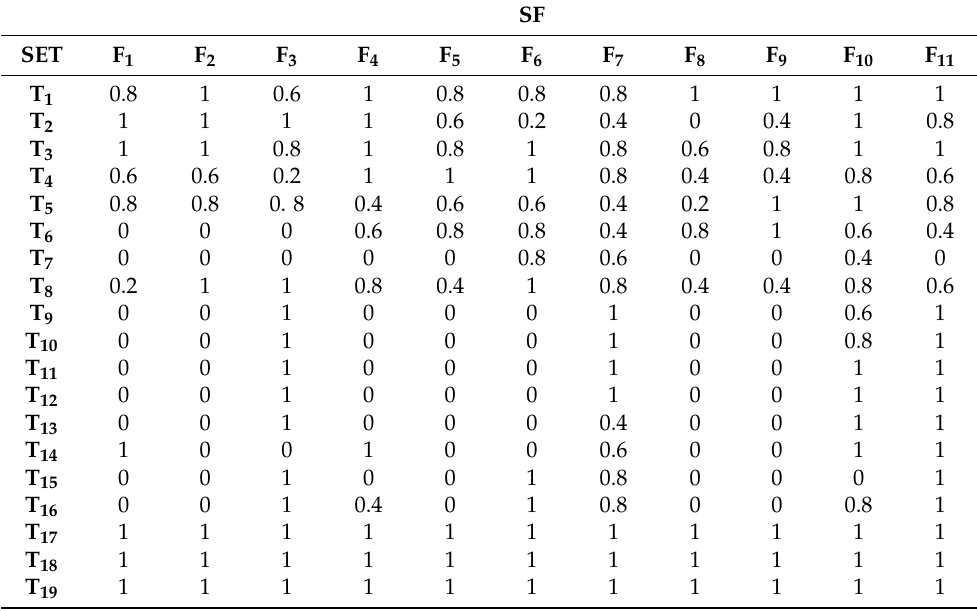
Figure 4. Compositions of fuzzy relations to attain the SETs–OOs composed fuzzy relation. Tables 3–6 show the expert’s assigned linguistic terms and corresponding numerical values for elements’ pair-wise relation. Table 4. Fuzzy relation matrix—SETs to SFs “Positively impact” relation—Numerical membership values.